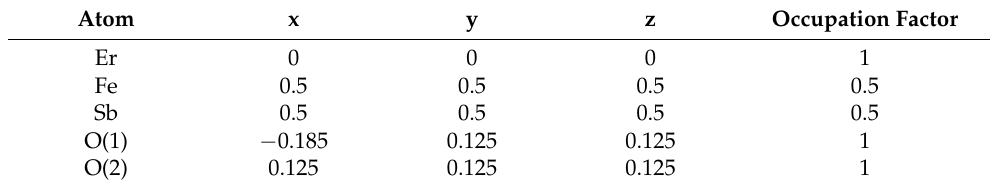
Figure 1. X-ray powder diffraction (XRD) patterns and Rietveld refinements of Er 2 FeSbO 7 (red dotted line represents experimental XRD data of Er 2 FeSbO 7 ; blue solid line represents simulative XRD data of Er 2 FeSbO 7 ; black solid line represents a difference between experimental XRD data of Er 2 FeSbO 7 and simulative XRD data of Er 2 FeSbO 7 ; green vertical line represents observed reflection positions). Table 1. Structural parameters of Er 2 FeSbO 7 prepared by solid reaction